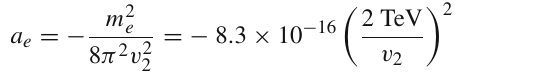
Both parameters ε and ˜ ε are normalised to 1 / 20 (cid:11) m μ / m τ ; ε 20 = 20 ε , ˜ ε = 20 ˜ ε . The latter choice is a clear overestimation and it would be 20 more consistent to take ˜ ε (cid:11) m e / m μ (cid:11) 1 / 200. However, we see that all of the LFV limits are respected even with strongly overestimated ˜